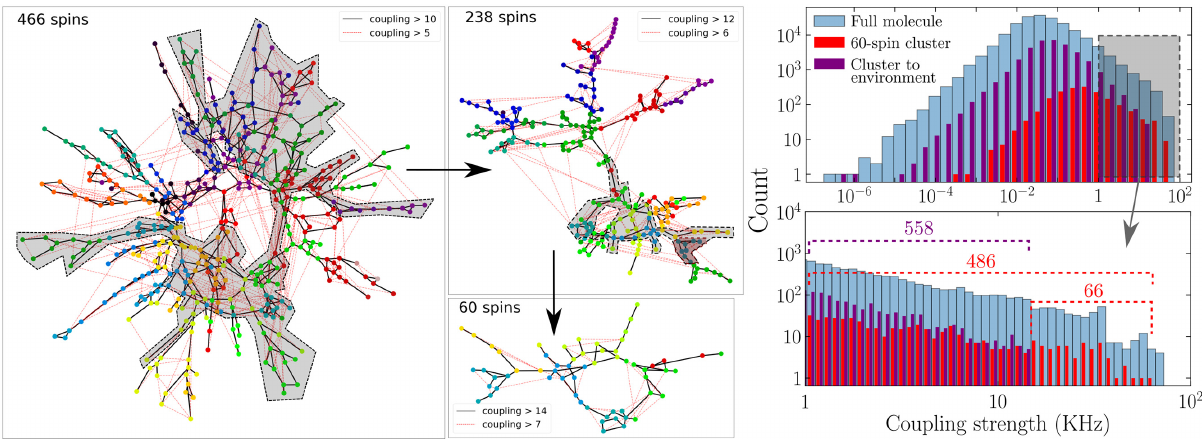
FIG. 4. Finding spin clusters within the ubiquitin protein using data from Ref. [126]. Left: a 466-spin cluster connected at a coupling of 10 KHz (the total protein has 692 H atoms). Middle top: a 238-spin subset of this cluster, connected at a coupling of 12 KHz. Middle bottom: a smaller 60-spin subset of this cluster, connected at a coupling of 14 KHz. Black lines and red dashed lines between spins indicate strong and medium-strength couplings within the cluster. Red dashed region in all three clusters is an eight-spin subcluster studied in this text. Right top: histogram of couplings within the 60-spin cluster and to the environment. Right bottom: an enlarged view of the histogram tail to show the distribution of the dominant